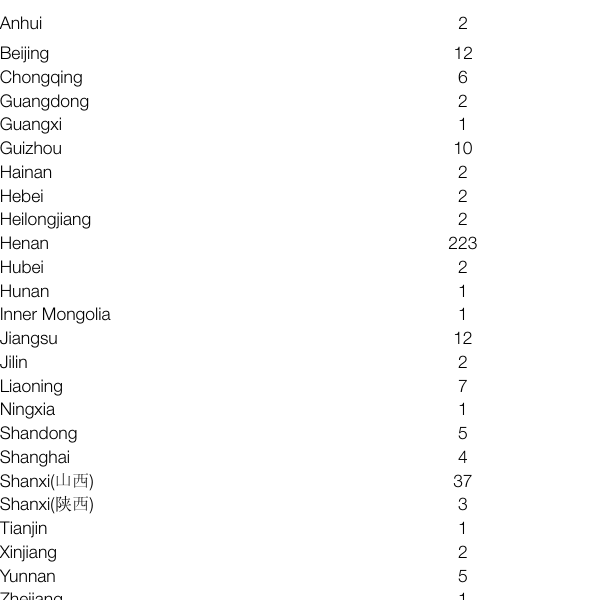
TABLE 1 | Demographic information of the participants from each